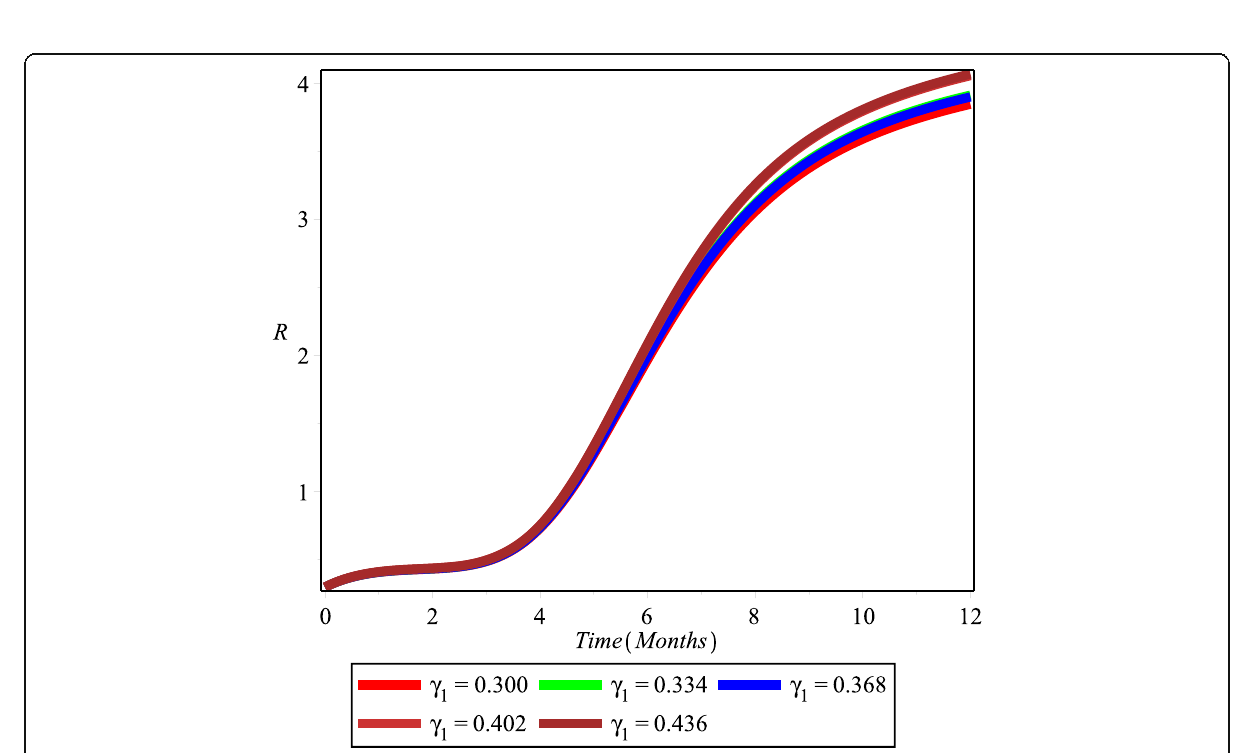
Fig. 5 Varying γ o (0.123 − 0.203) when R r < 1